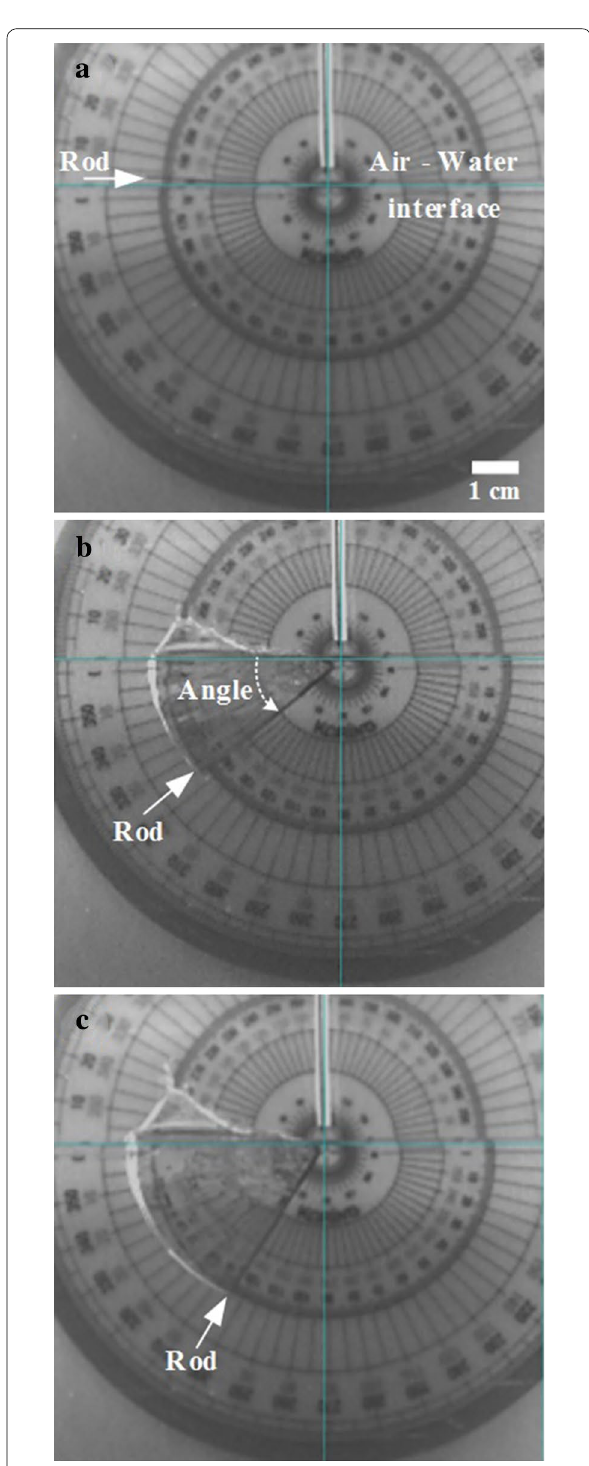
Fig. 3 Time lapse series of images of rotation of a 4‑cm‑long rod: a 0 ms, b 4 ms, and c 8.4